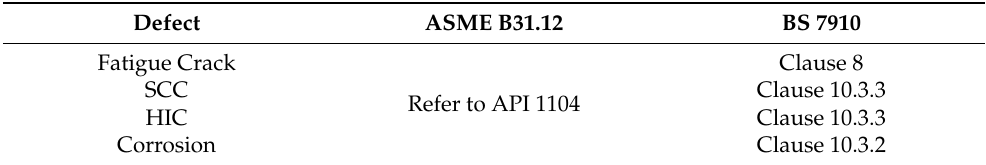
Table 7. An overview of the acceptance criteria for each defect produced during operation according to ASME B31.12 and BS 7910 [94–97].